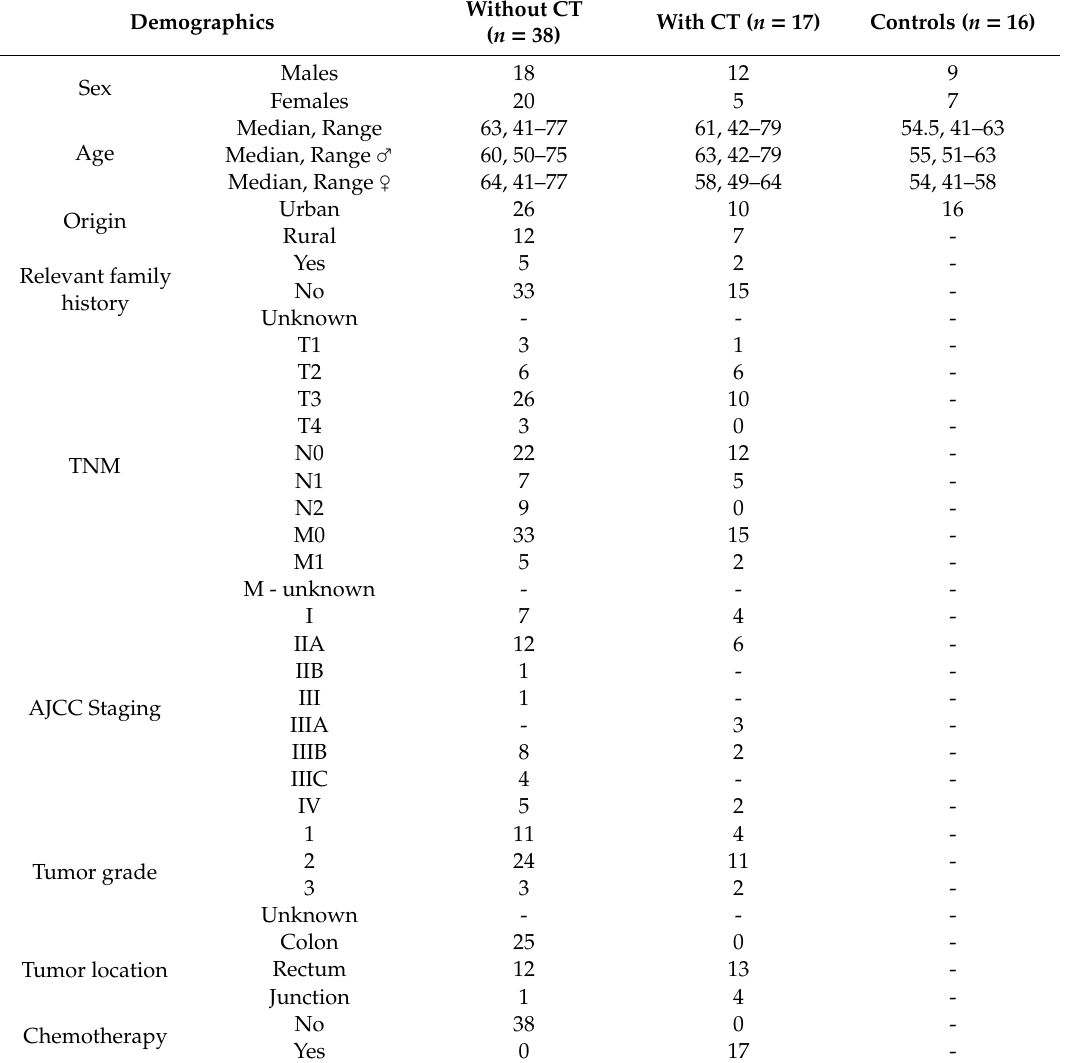
Table 2. Clinical data for the patients used for microarray study, representing 38 cases without chemotherapy (CT), 17 with CT and 16 healthy